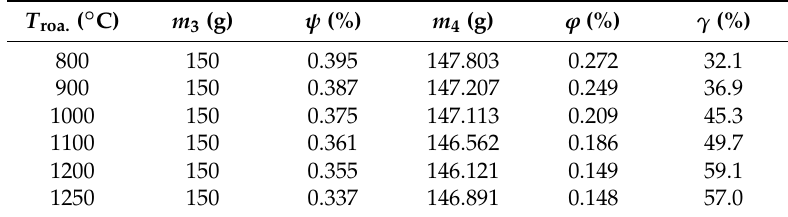
Table 3. Masses and vanadium contents of the samples before and after leaching and vanadium liquor to solid: 3:1, leaching agent: 100 g/L